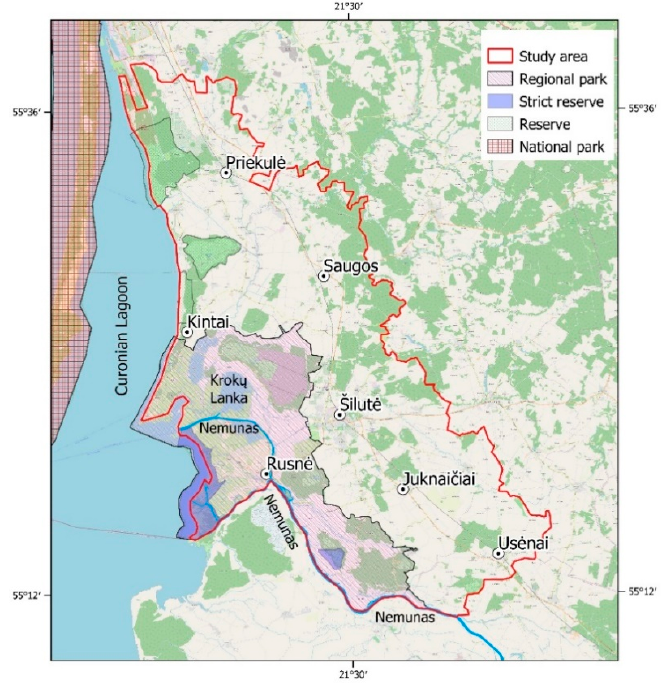
Figure 1. Study area and its location on the map of Lithuania (distribution map made by D. Gozdowski).